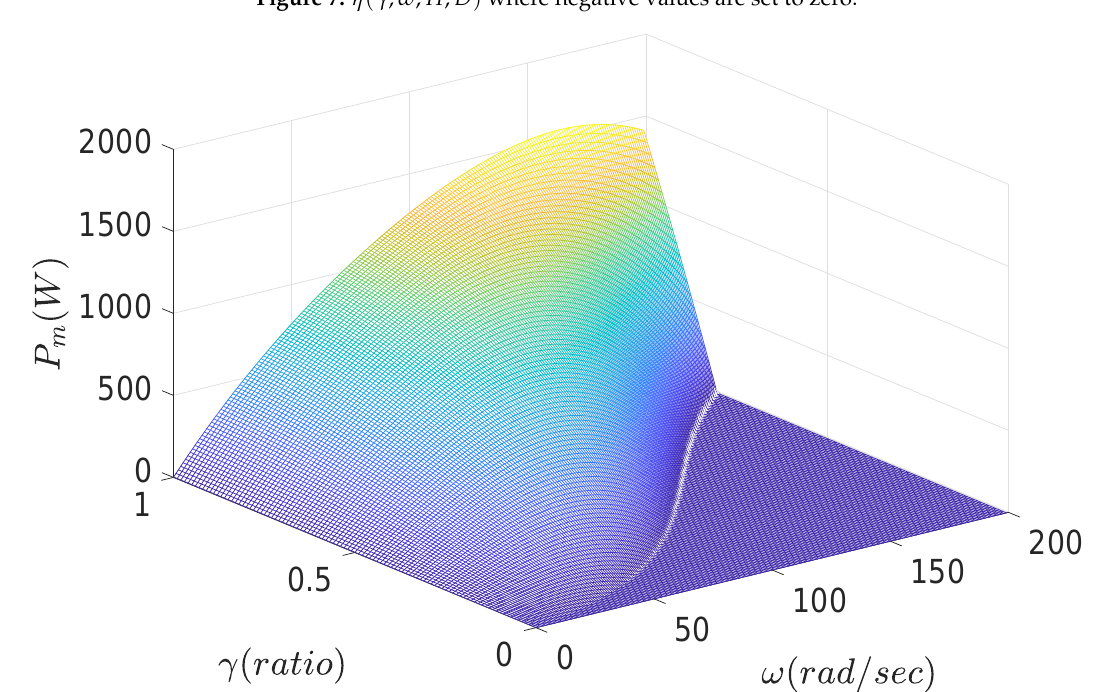
Figure 8. P m ( γ , ω , H , D ) where negative values are set to